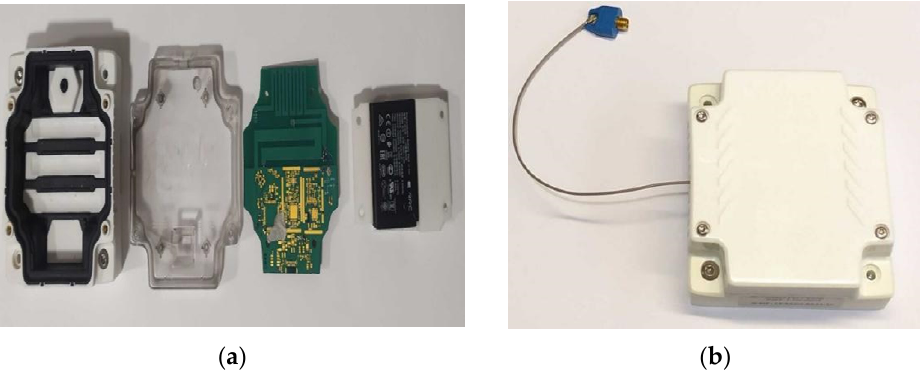
Figure 11. Prototyped tracker device: ( a ) prototyped antenna and the different parts of the connected device; ( b ) assembled connected device (tracker).